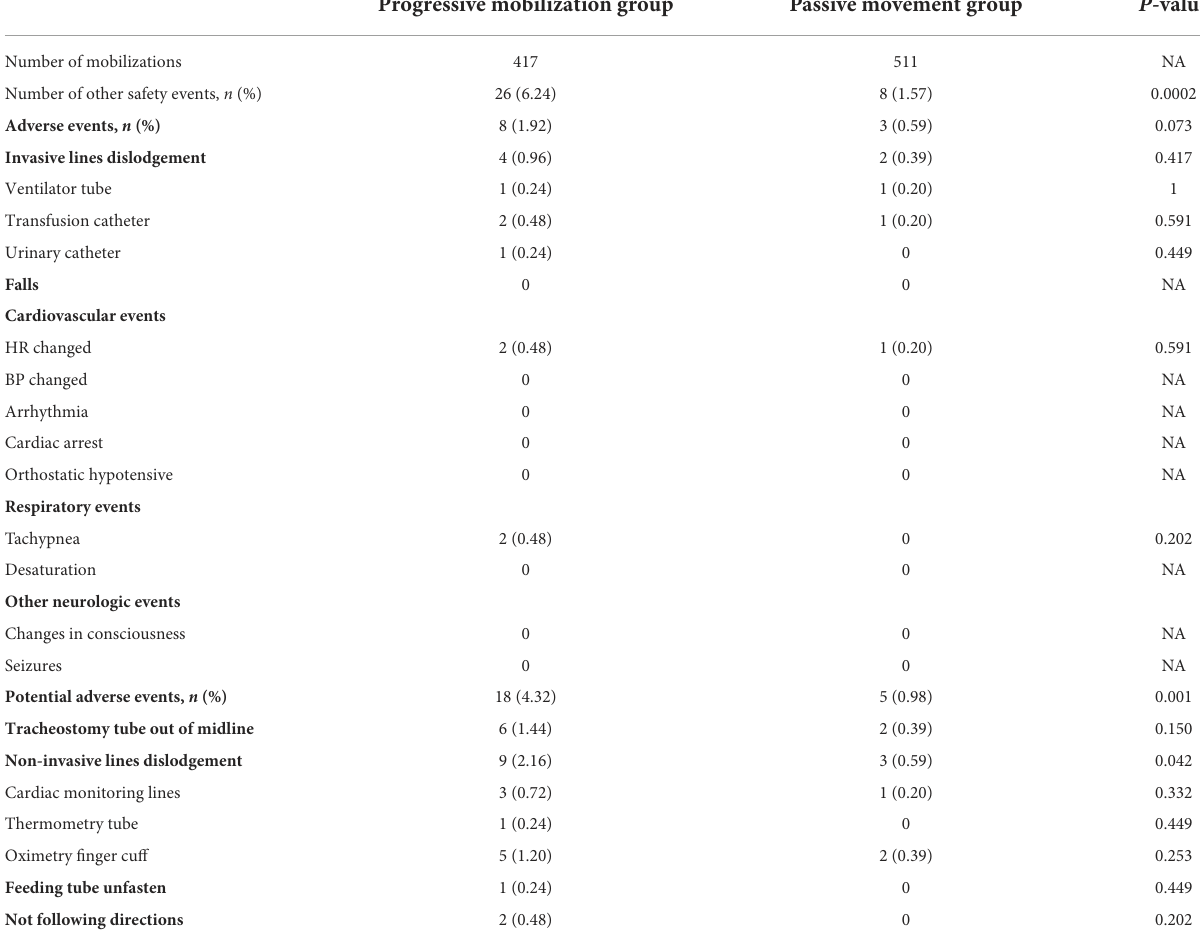
TABLE 5 Comparison of other safety events between the two groups. Progressive mobilization group Passive movement